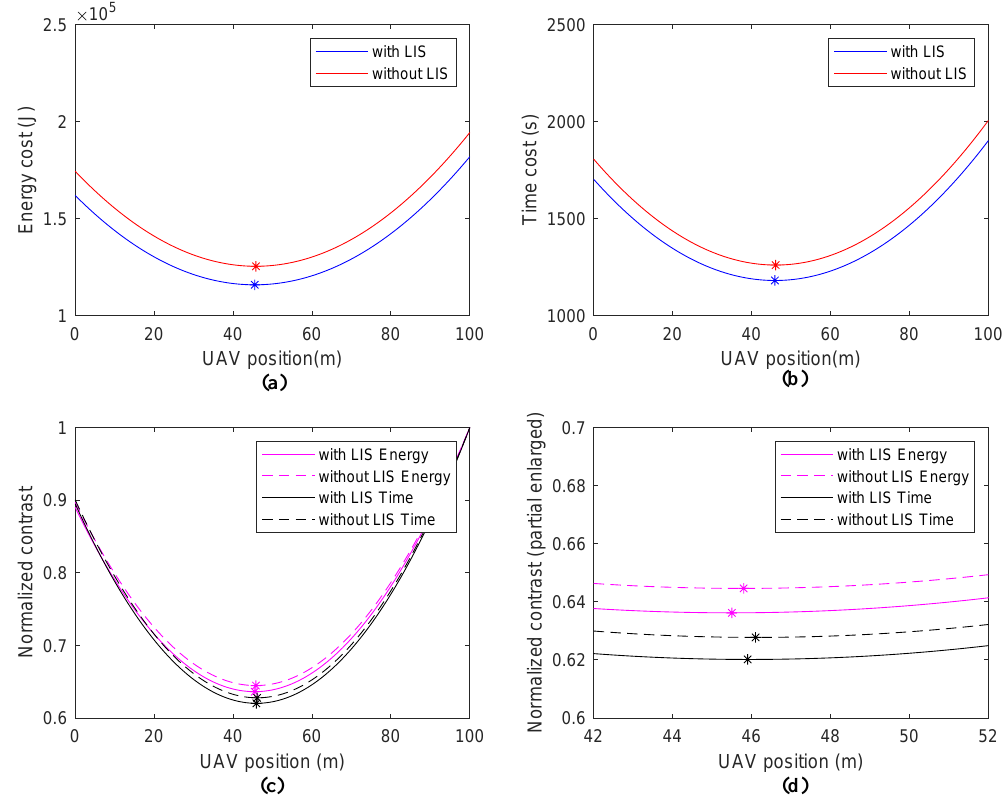
Figure 10. Simulation results of Scene III : ( a ) energy cost, ( b ) time cost, ( c ) normalized contrast, and ( d ) normalized contrast (partial